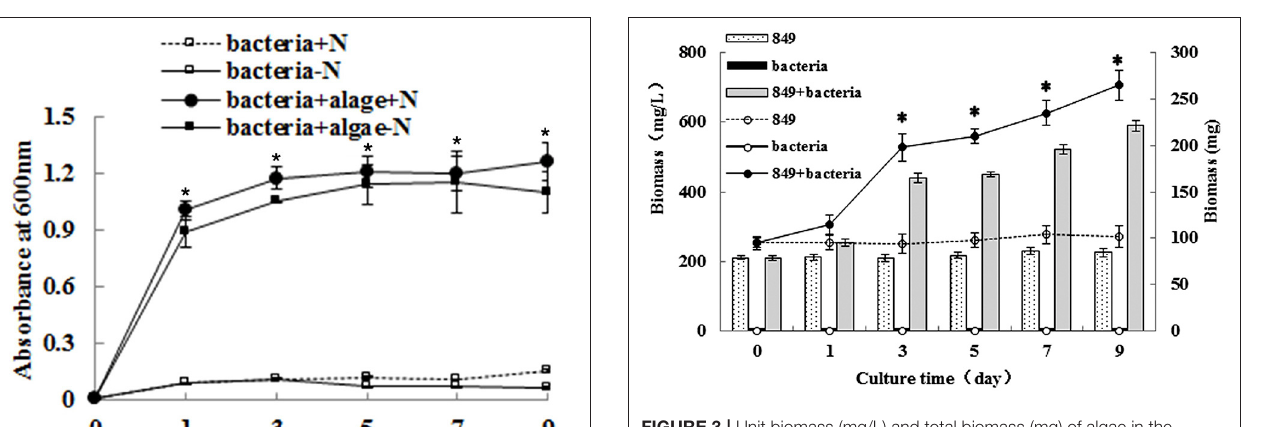
FIGURE 3 | Unit biomass (mg/L) and total biomass (mg) of algae in the co-culture were measured on days 0, 1, 3, 5, 7, and 9 after incubation in a nitrogen-deprived medium. Pure algae culture was used as the controls. Unit biomass is shown with bars and total biomass is shown with dashed and solid lines, respectively. *significant difference between the experimental and control groups. The vertical bars indicate standard errors calculated from at least three independent